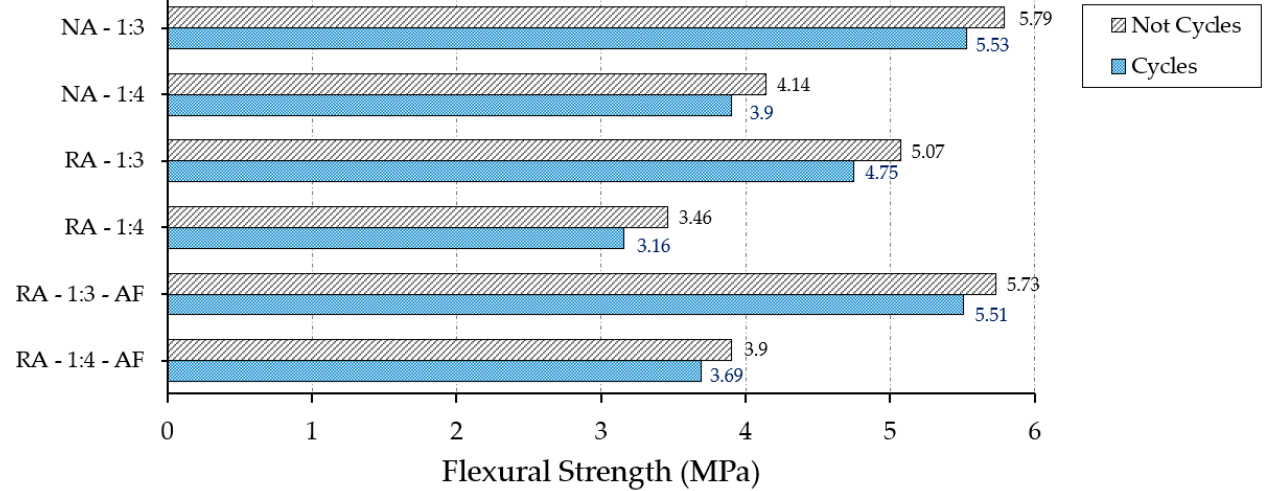
Figure 6. Flexural strength test results derived from the freezing test for cycled and uncycled specimens. Table 14. Loss of mass in grams and percentage decrease in flexural mechanical strength of specimens subjected to freeze– thaw cycling [74].